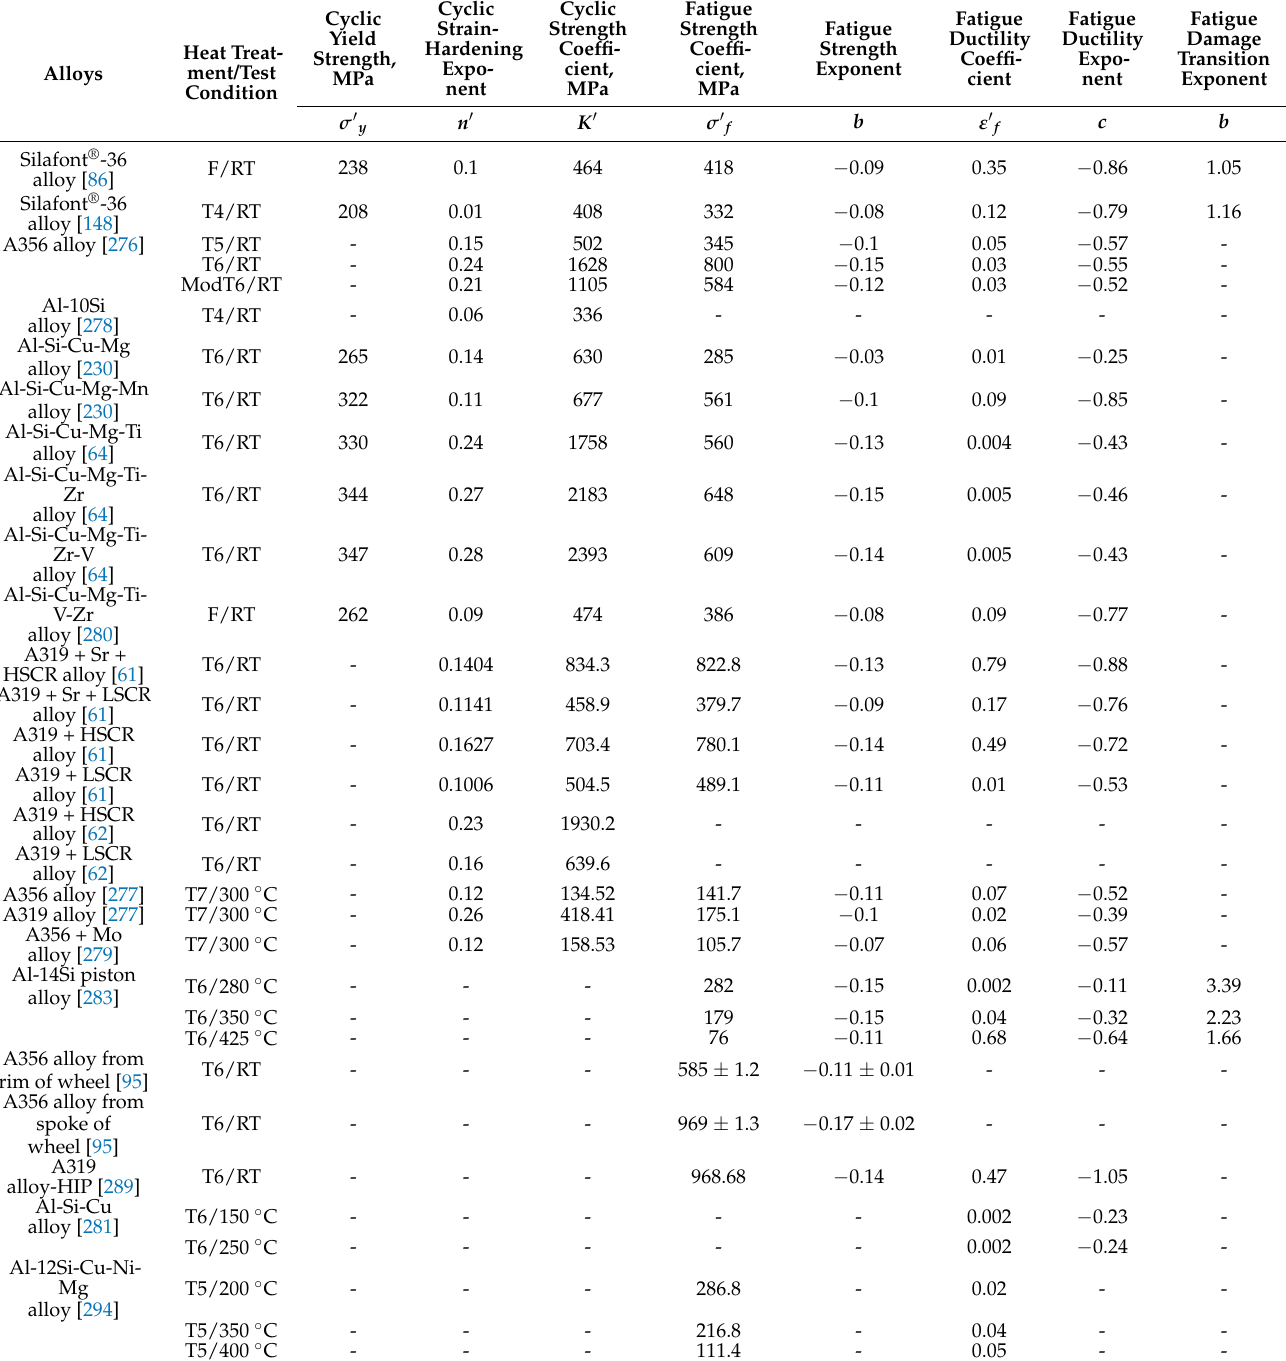
Table 6. LCF parameters from Coffin–Manson–Basquin equations for cast and heat-treated Al-Si